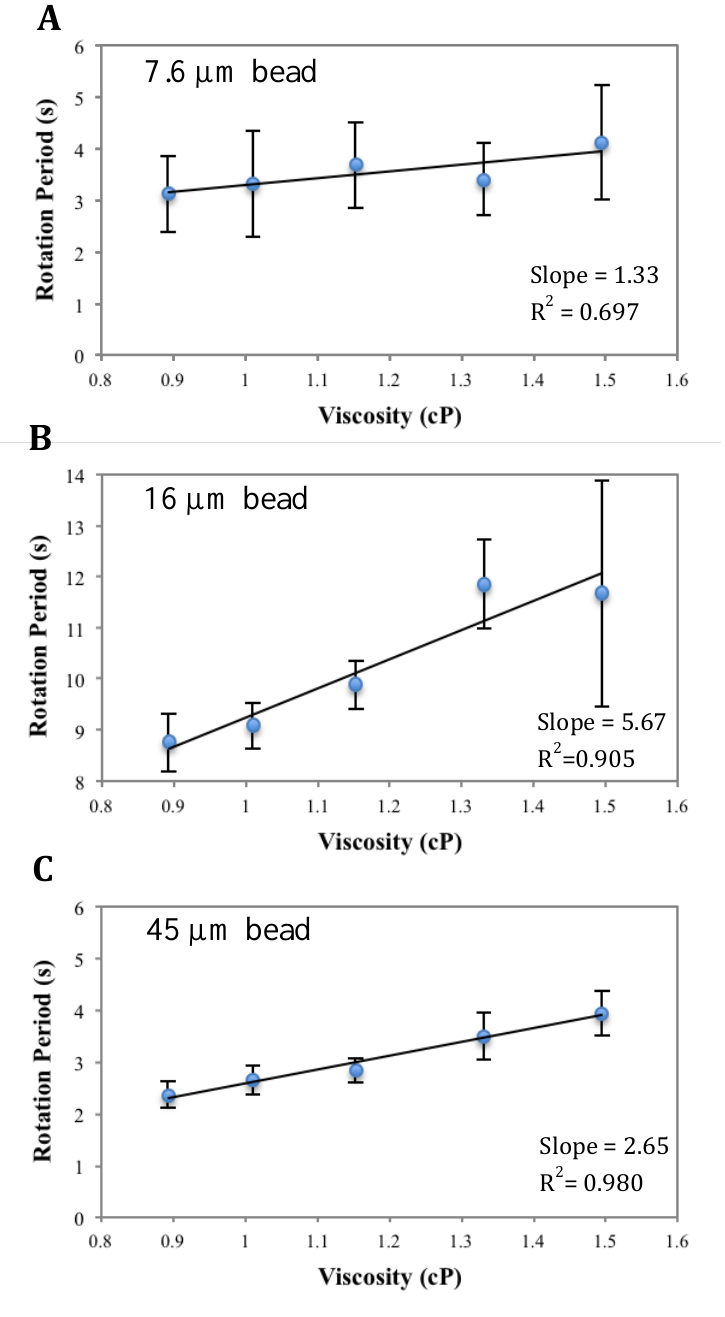
Figure A3. Calibration curves at 100 Hz using beads of different sizes. A : 7.6 µm; B : 16 µm; C : 45 µm. Error bars represents standard deviation among 10 beads in one